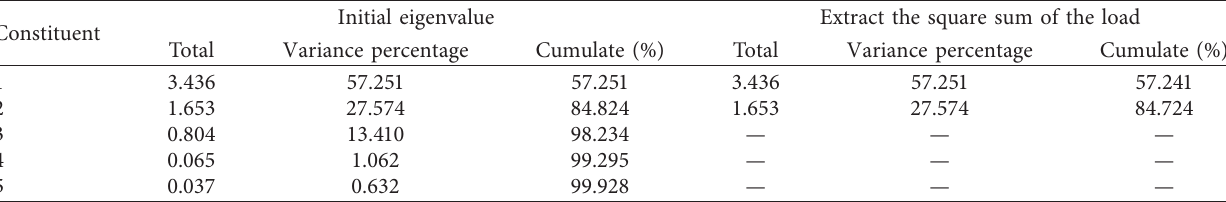
Table 3: Explanation of total variance.